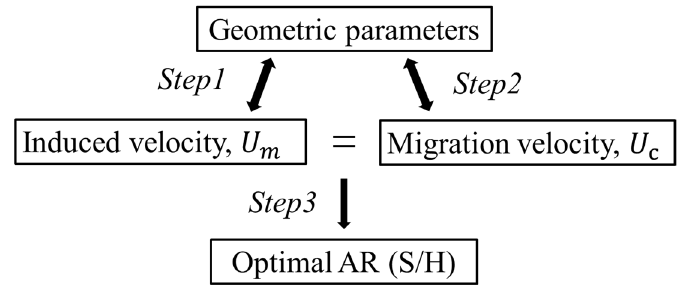
Figure 4. Strategies for solving the analytic solution of optimal AR .